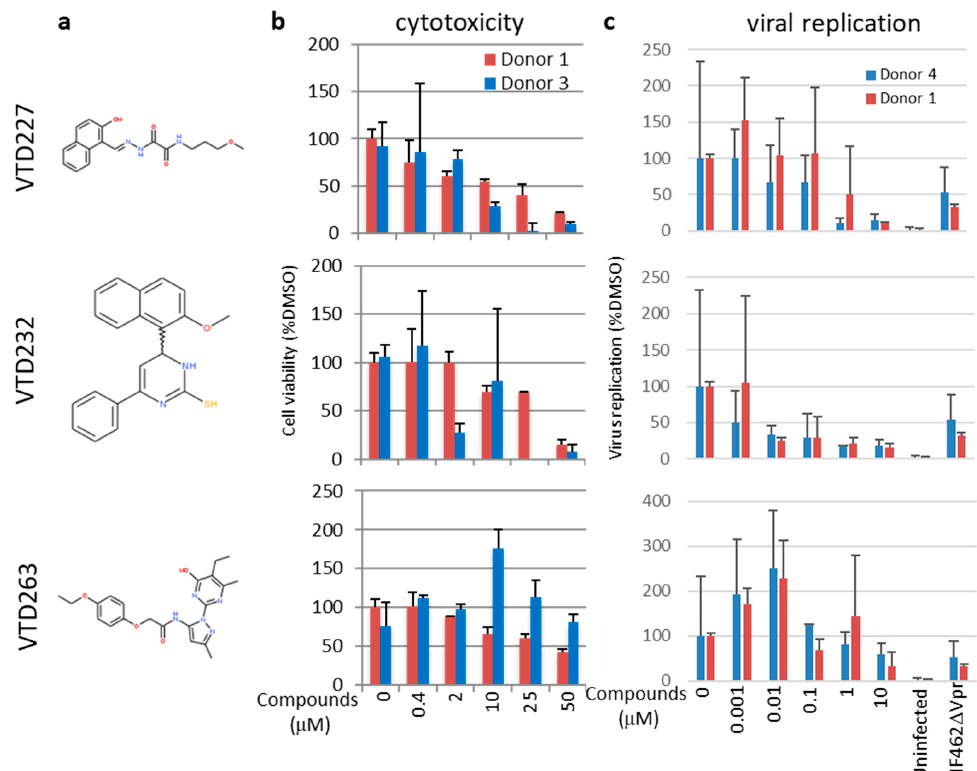
Figure 4. The inhibitory activity of selected compounds on the virus replication in HIV-1 NF462- infected human monocyte-derived macrophages (MDM). ( a ) Structure of the final selected compounds, VTD227, VTD232, and VTD 263. ( b ) Dose-dependent cell cytotoxicity for MDM of the final selected compounds. Differentiated MDM from healthy donors 1 and 3 were treated with 0, 0.4, 2, 10, 25, or 50 μ M of 4 candidate compounds for 48 h, and cell viability was assessed by WST-1 assay. ( c ) Inhibition on the replication of HIV-1 NF462 by the final selected compounds. Differentiated MDM from healthy donors 1 and 4 were infected either with NF462 HIV-1 or NF462delVpr and replaced with a new medium containing 0, 0.001, 0.01, 0.1, 1, or 10 μ M of 4 candidate compounds. The cells were maintained for 8 days, and the levels of virus production in the culture supernatants were measured by the p24 antigen, ELISA. A calculated 50% replication inhibitory concentration (IC 50 ) and 50% cytotoxic concentration (CC 50 ) are shown in Table 2. Each column and error bar represent the mean SD of the results from the duplicate samples from two donors.